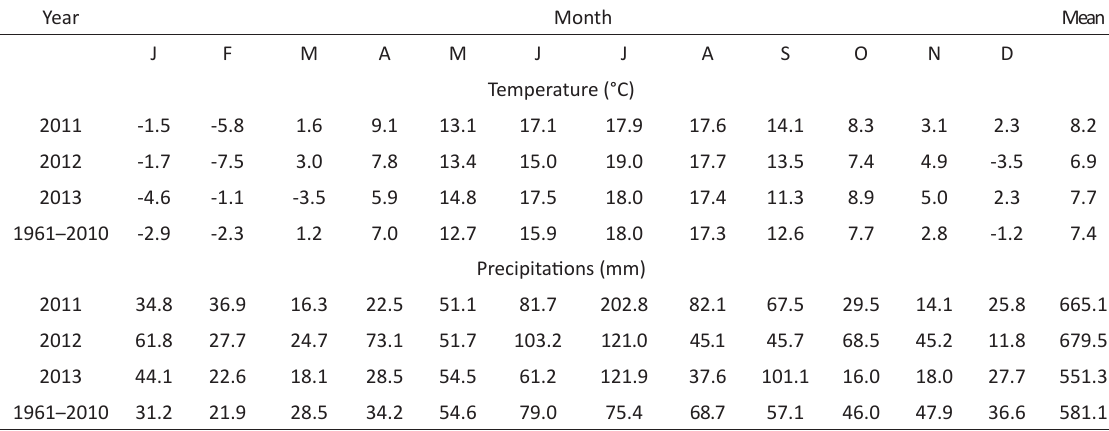
Table 2. Meteorological